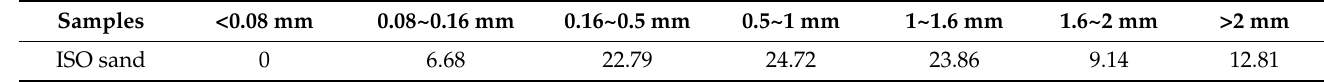
Table 4. Particle size of ISO sand.